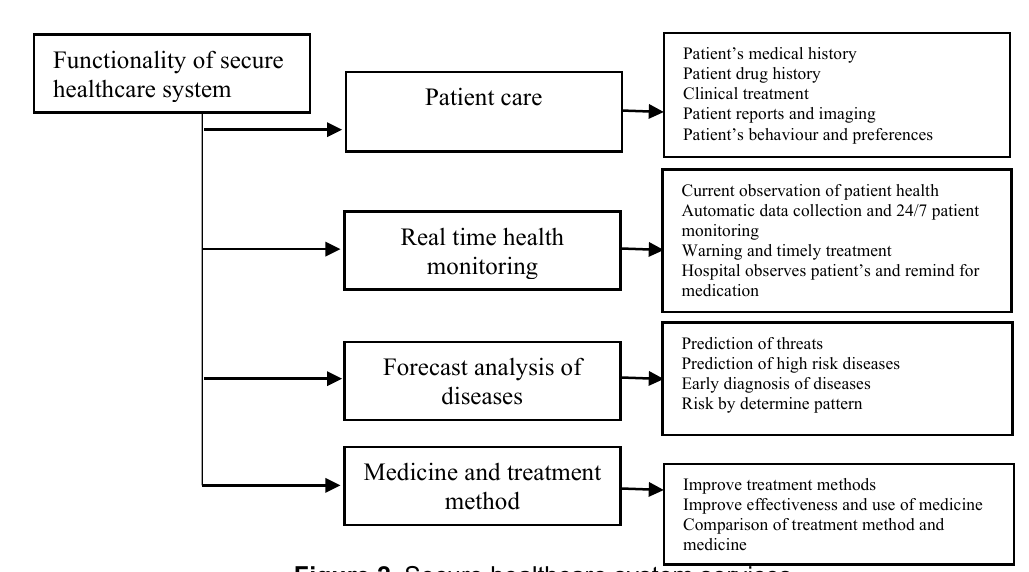
Figure 2 : Secure healthcare system services